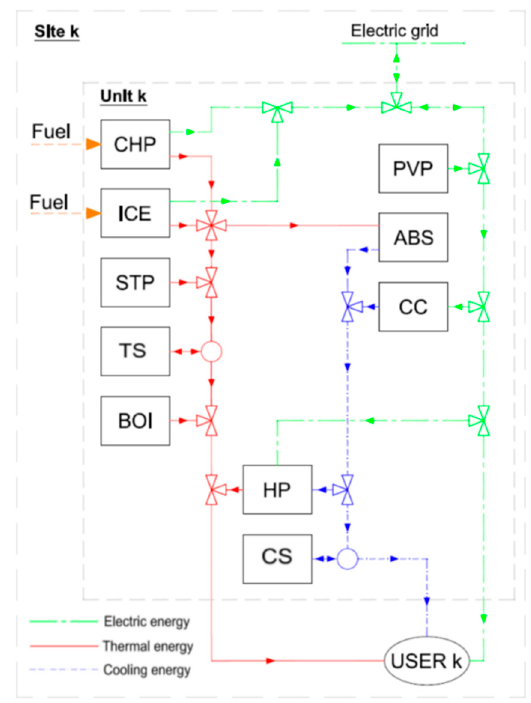
Figure 6. Superstructure of the isolated solution with TSs.